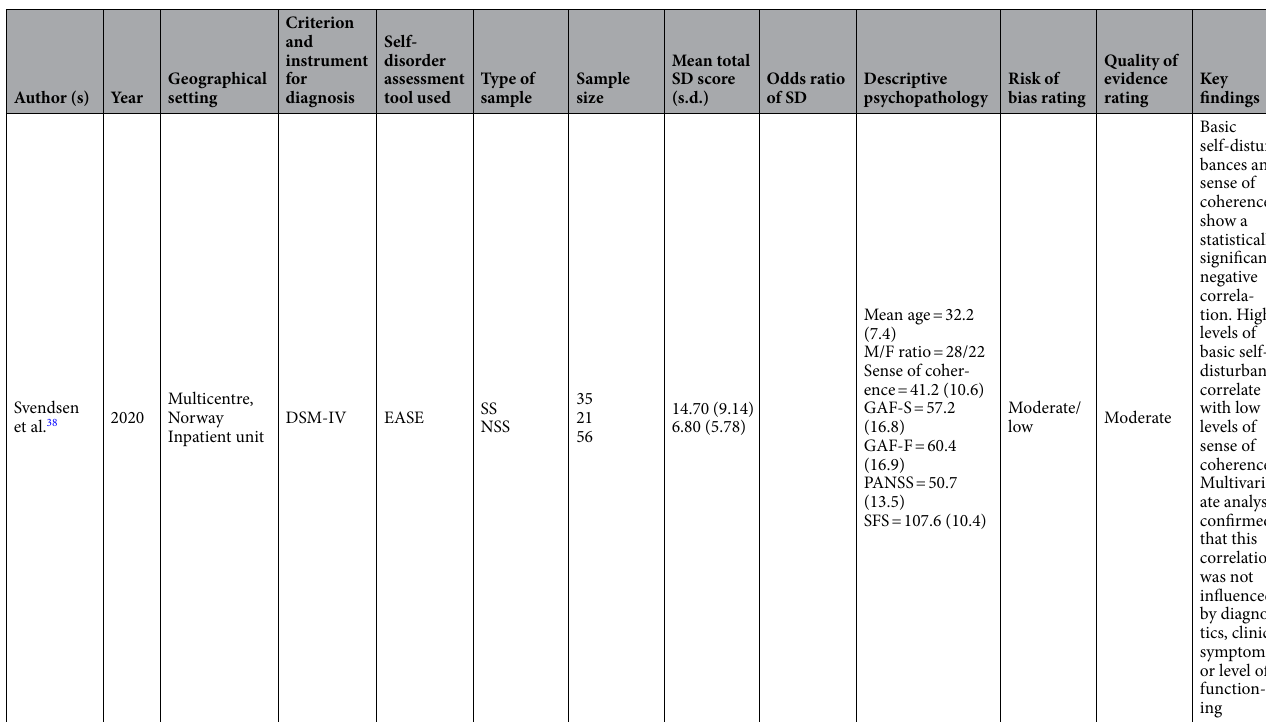
Table 1. Summary table of included studies reporting the following: main author(s), geographical setting, criterion/instrument for diagnosis, SD assessment tool, type of sample, sample size, mean total SD score, odds ratio of SD, descriptive psychopathology, risk of bias rating, quality of evidence rating, and key findings. Total SD score reported as either mean ± SE or median ± IQR. Odds ratios as log odds ± SE. Values are significant if p < 0.05. ASD = autism spectrum disorder, ASE = anomalous self-experience, BD = bipolar disorder, BPRS = brief psychiatric rating scale, BSABS = Bonn scale for the assessment of basic symptoms, CAARMS = comprehensive assessment of at risk mental states, EASE = Examination of anomalous self-experiences, EAWE = examination of anomalous world-experiences, DSM = diagnostic and statistical manual, F = female, FEP = first episode psychosis, FRS = first rank symptoms, GAF = global assessment of functioning, HC = healthy control, ICD = international classification of diseases, M = male, MD = mood disorder, NAP = non-affective